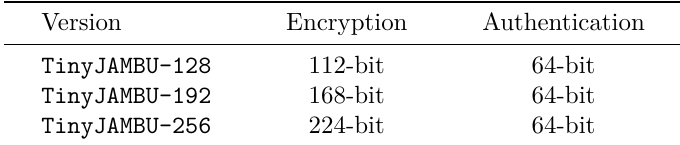
Table 2: Security goals of TinyJAMBU with unique nonce [WH19, Table